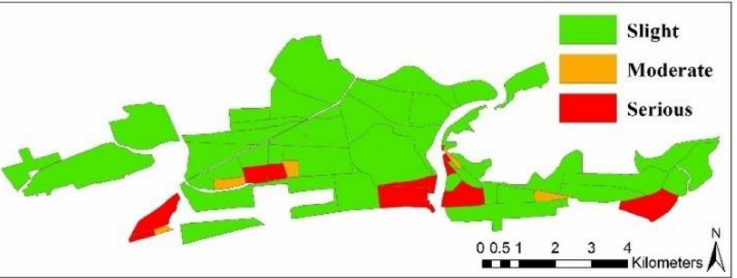
Figure 5. The block-level reference map of building damage in the Ishinomaki study